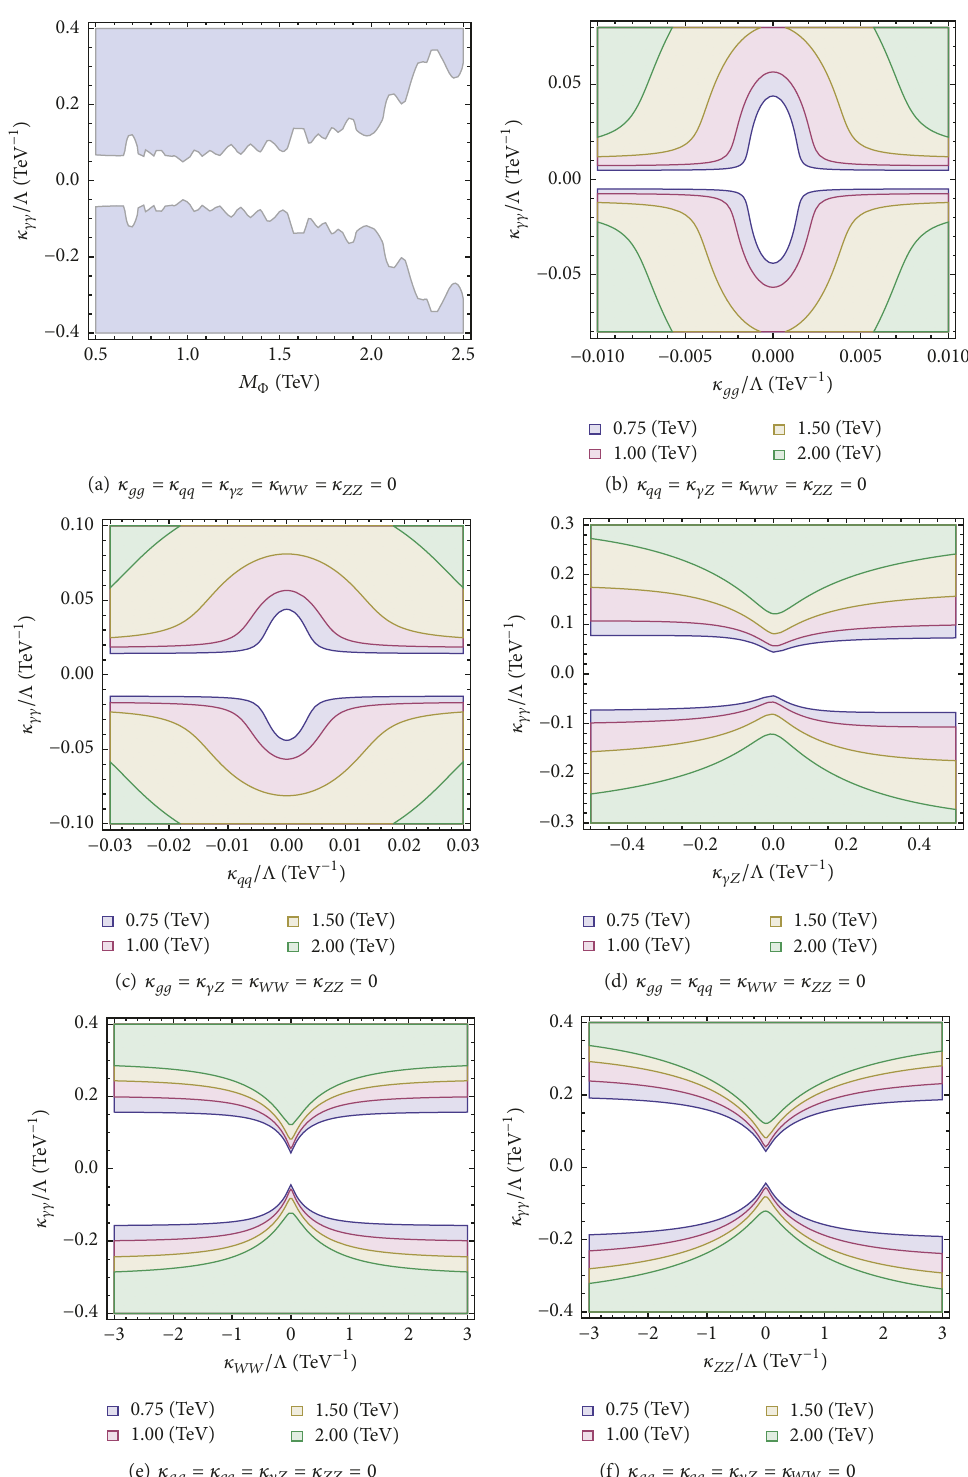
Figure 3: Exclusion regions using the observed upper limits (with 95% confidence level) on 𝜎× BR for the spin-0 diphoton resonance search by ATLAS [29] ( √ 𝑠 = 13 TeV, L = 36.7 fb −1 ). (a) Exclusions in the 𝑀 Φ - 𝜅 𝛾𝛾 /Λ plane setting all other 𝜅 𝑥𝑦 = 0 . (b)–(f) Exclusions in the 𝜅 /Λ - 𝜅 /Λ plane while setting all other 𝜅 𝑥𝑦 𝛾𝛾